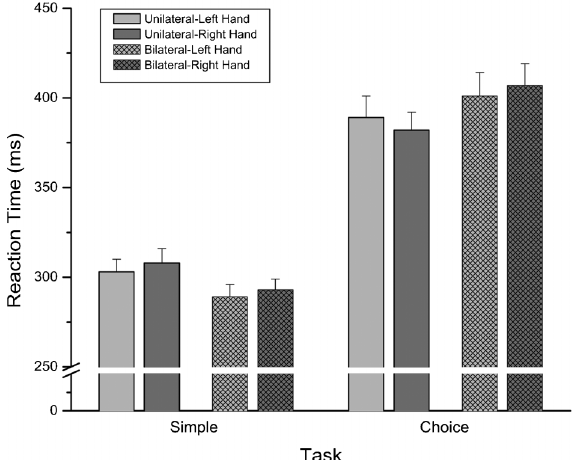
Figure 2. Left hand and right hand reaction times in milliseconds for the unilateral and bilateral responses in the simple and choice tasks. Data are reported as means±SE for 16 participants. P . 0.05 comparing left and right hands (repeated measures analysis of variance followed by the Tukey